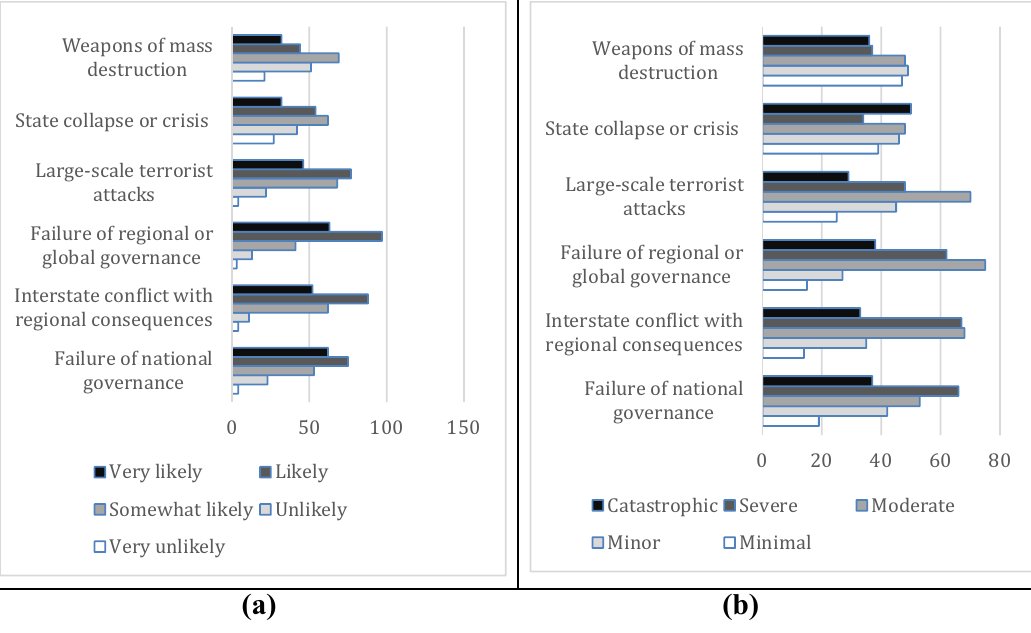
Fig. 3 Stated likelihoods ( a ) and consequences ( b ) of the global geopolitical risks by the surveyed small and medium enterprises in